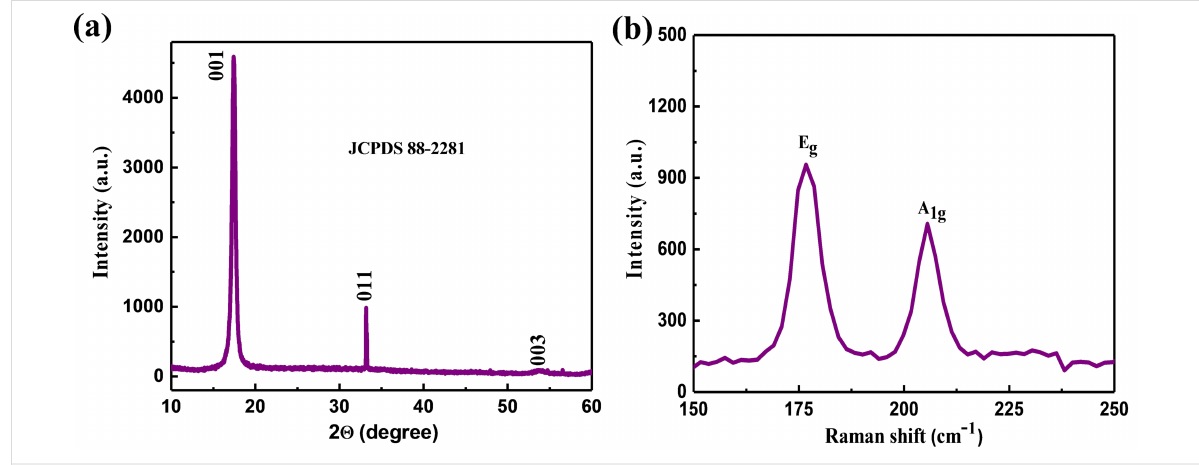
Figure 1: PtSe 2 nanosheets. (a) Typical XRD pattern and (b) Raman spectra recorded at room temperature.